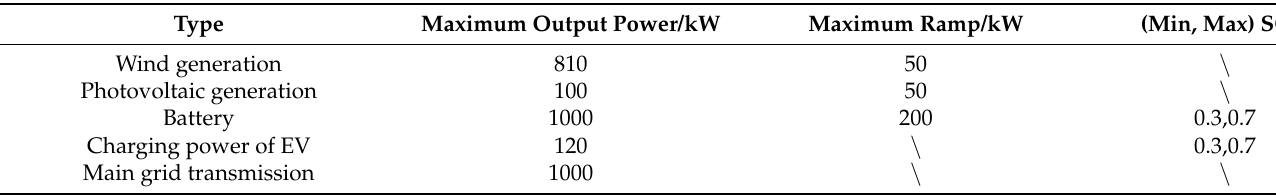
Table 5. Status of various components in the microgrid.